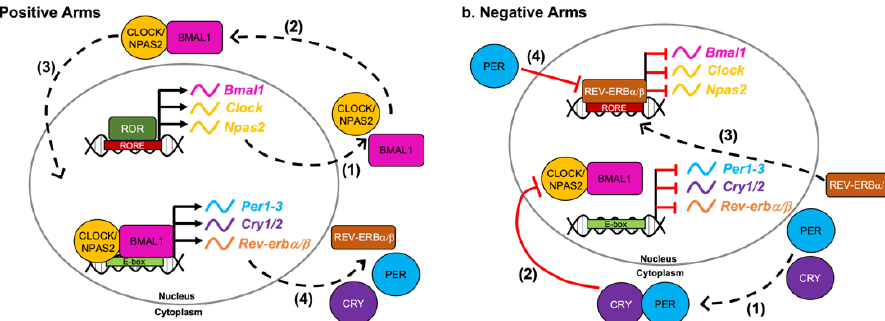
Figure 1. The Circadian Transcription–Translation Feedback Loop (TTFL). ( a ) Positive arms of the TTFL (1) ROR binding to the RORE initiates transcription of Bmal1 , Clock and Npas2 , which are shuttled to the cytoplasm for translation. (2) BMAL1 and CLOCK/NPAS2 form a complex in the cytoplasm. (3) The BMAL1:CLOCK/NPAS2 complex translocates to the nucleus where it binds to E-box elements to (4) upregulate transcription of Per , Cry and Rev-erb α / β and other core clock genes; ( b ) Negative arms of the TTFL (1) PER and CRY form a complex that (2) translocates to the nucleus and inhibits the transcriptional activity of BMAL1::CLOCK/NPAS2. REV-ERB α / β translocates to the nucleus and represses the transcription of Bmal1 , Clock and Npas2 . (4) PER monomers inhibit REV-ERB α / β